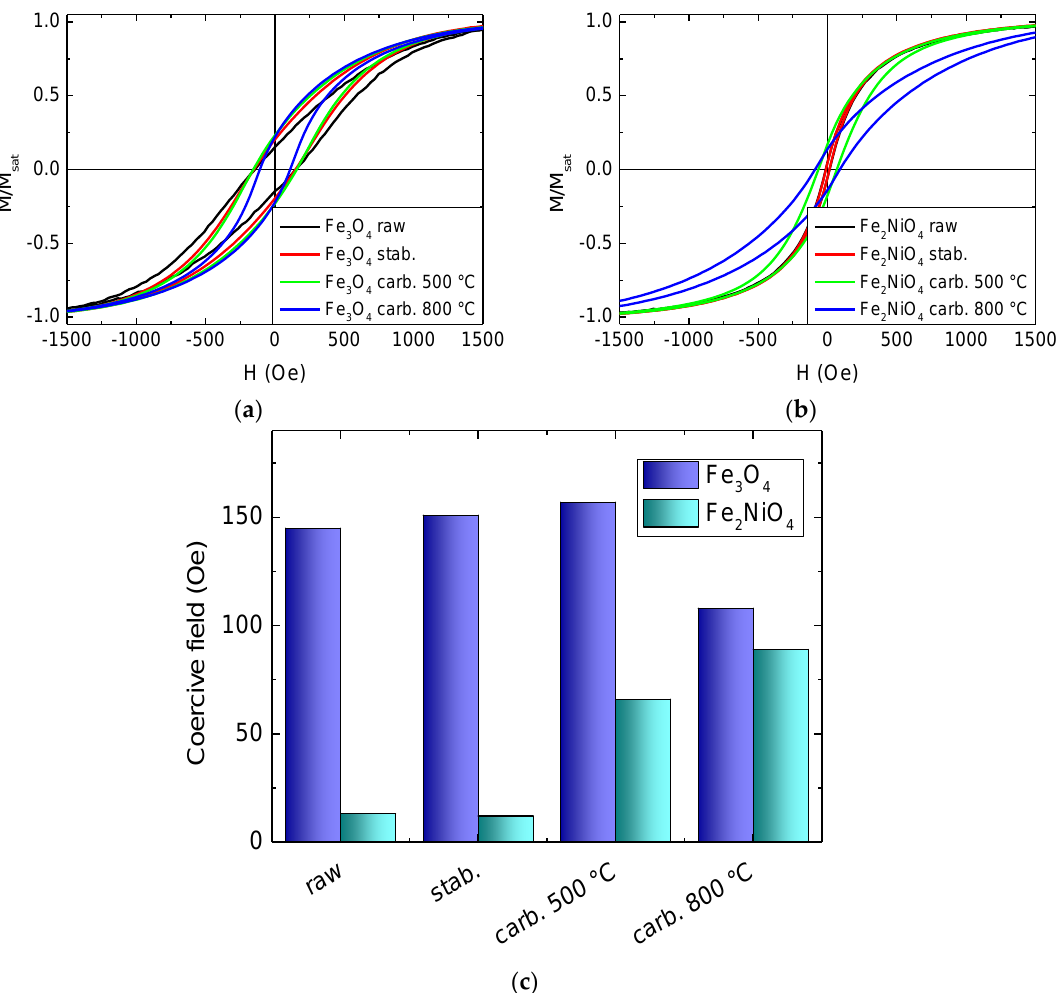
Figure 7. Alternating gradient magnetometer (AGM) measurements of hysteresis loops, performed on magnetic nanofibers including nanoparticles from ( a ) magnetite; ( b ) nickel-ferrite; and ( c ) coercive fields measured on these samples.